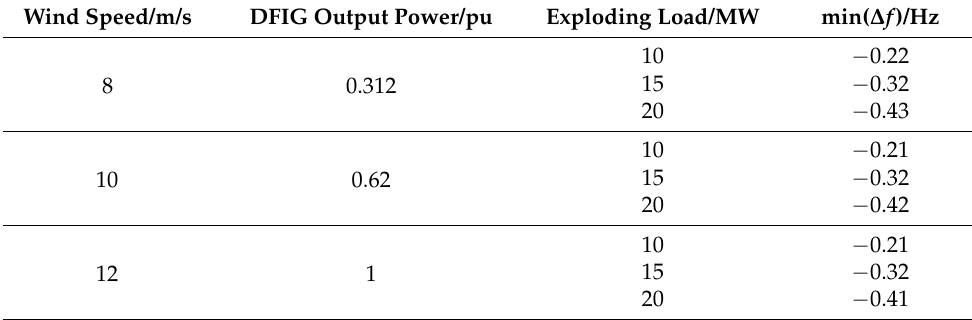
Table 2. System frequency